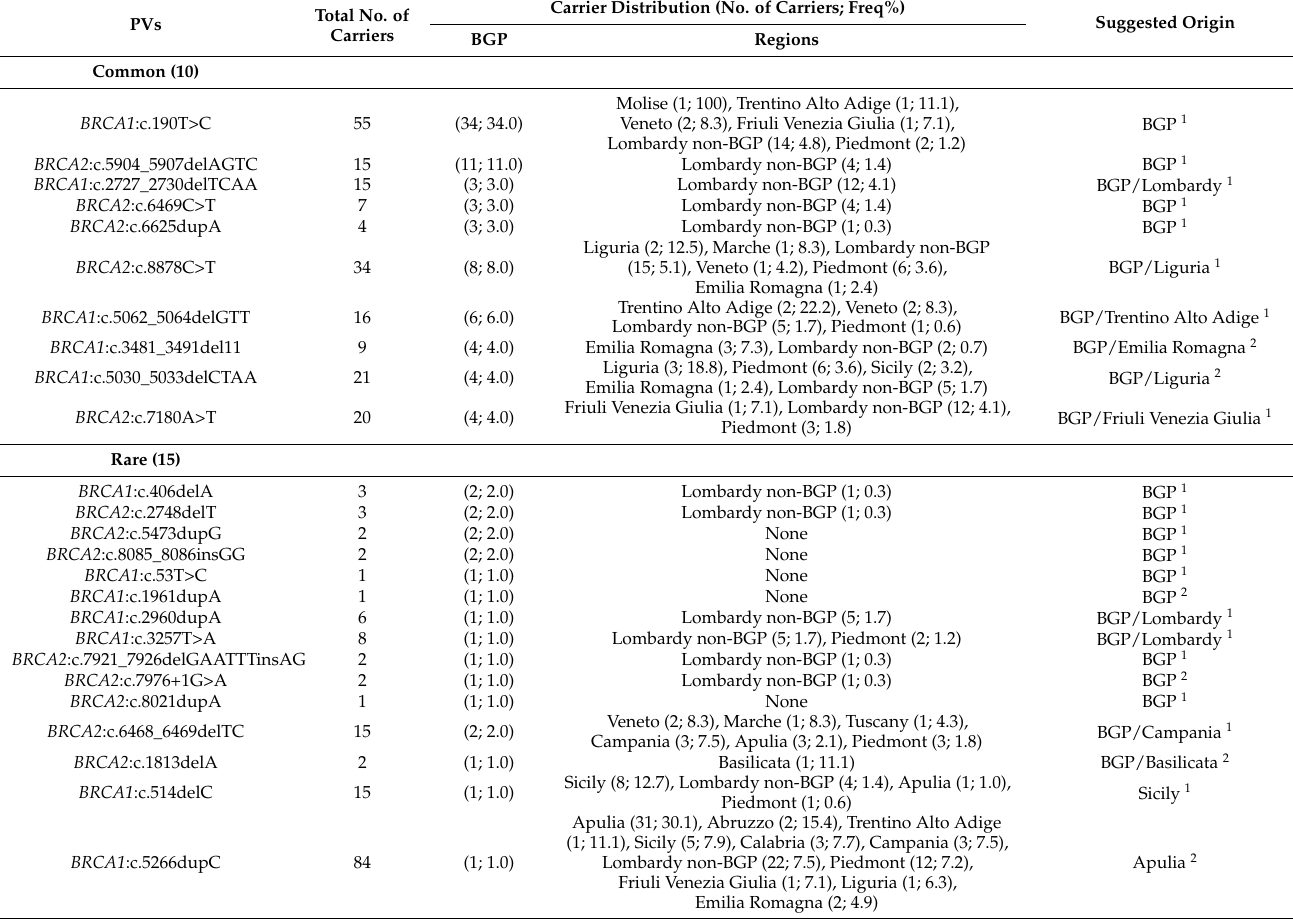
Table 1. Distribution of the 25 Bergamo province (BGP) pathogenic variants (PVs).